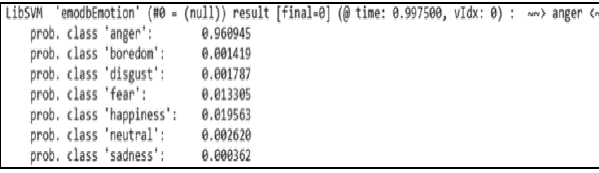
On the other hand, for the same database, classification of Sadness samples results in a low accuracy, 45%. Plotting the same graphs for Sadness shows distinct results. Figure 5 shows the histogram only for Sadness samples, while Figure 6 compares histograms of Sadness with all samples, including